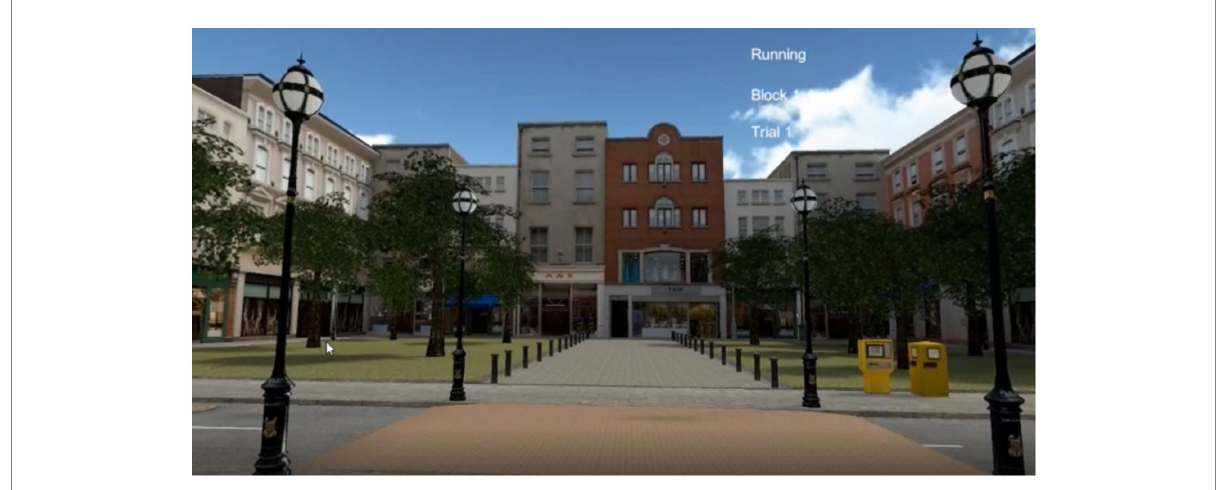
FIGURE 2 Street scene 1 of the VR experiment.